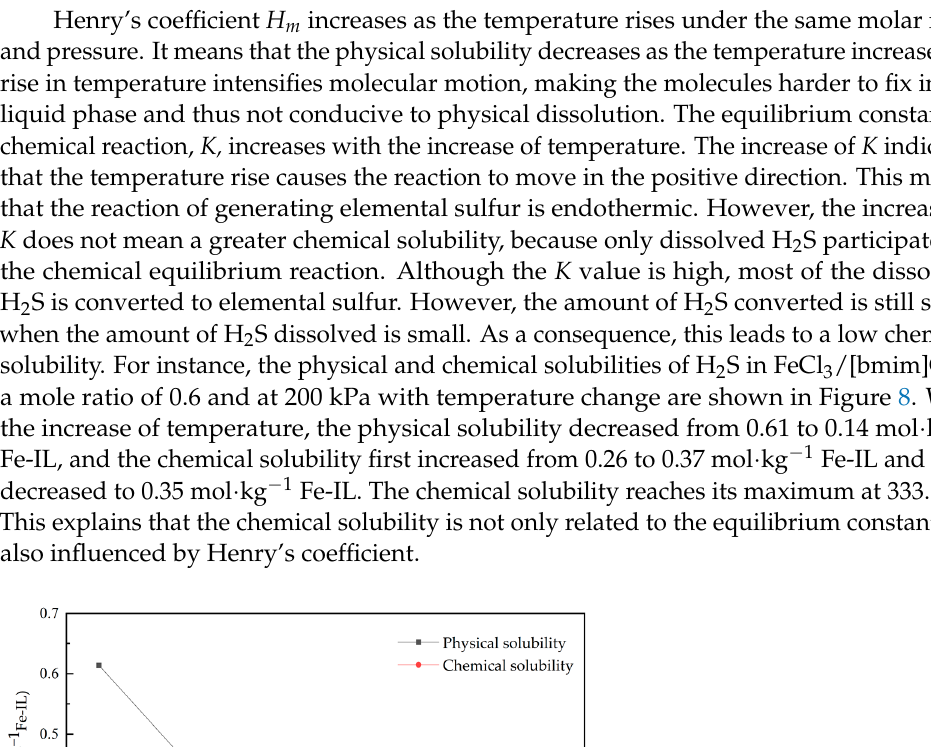
Table S1: Density data from the literature, Table S2: Total solubility (m H2S,t ) of H 2 S in different composition ratios of rFeCl 3